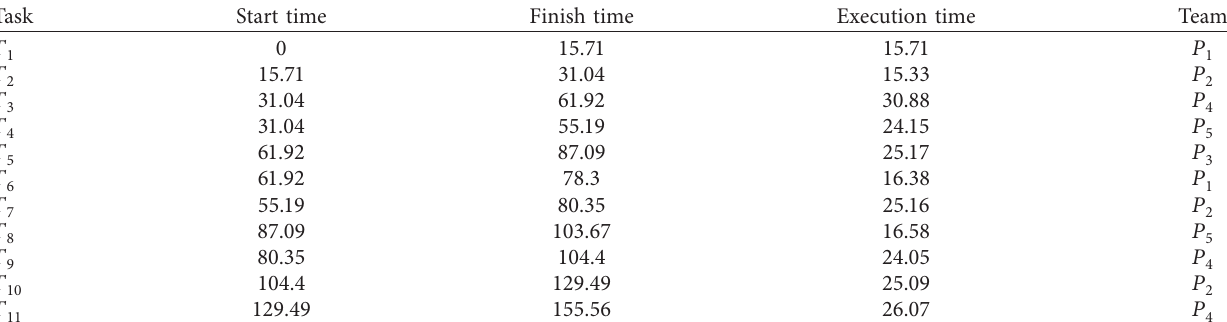
Figure 8: Gantt chart for task Table 9: The task assignment scheme.